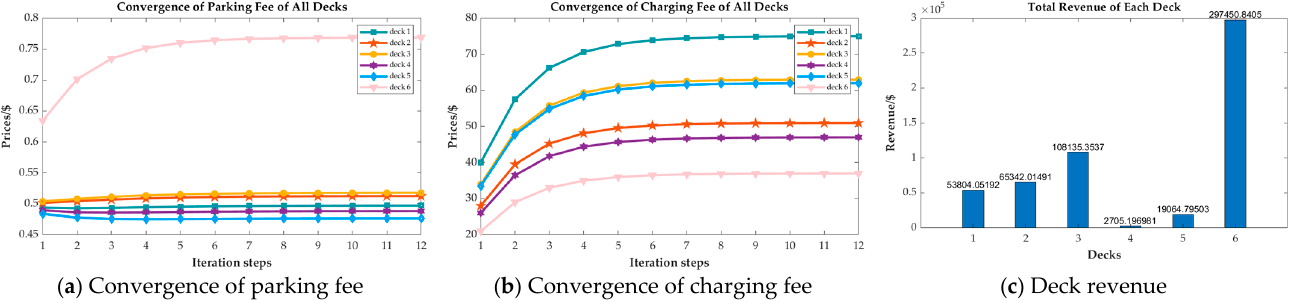
Figure 4. The charging price, parking fee, and total revenue after the number of SC customers in deck 6 was reduced to zero.